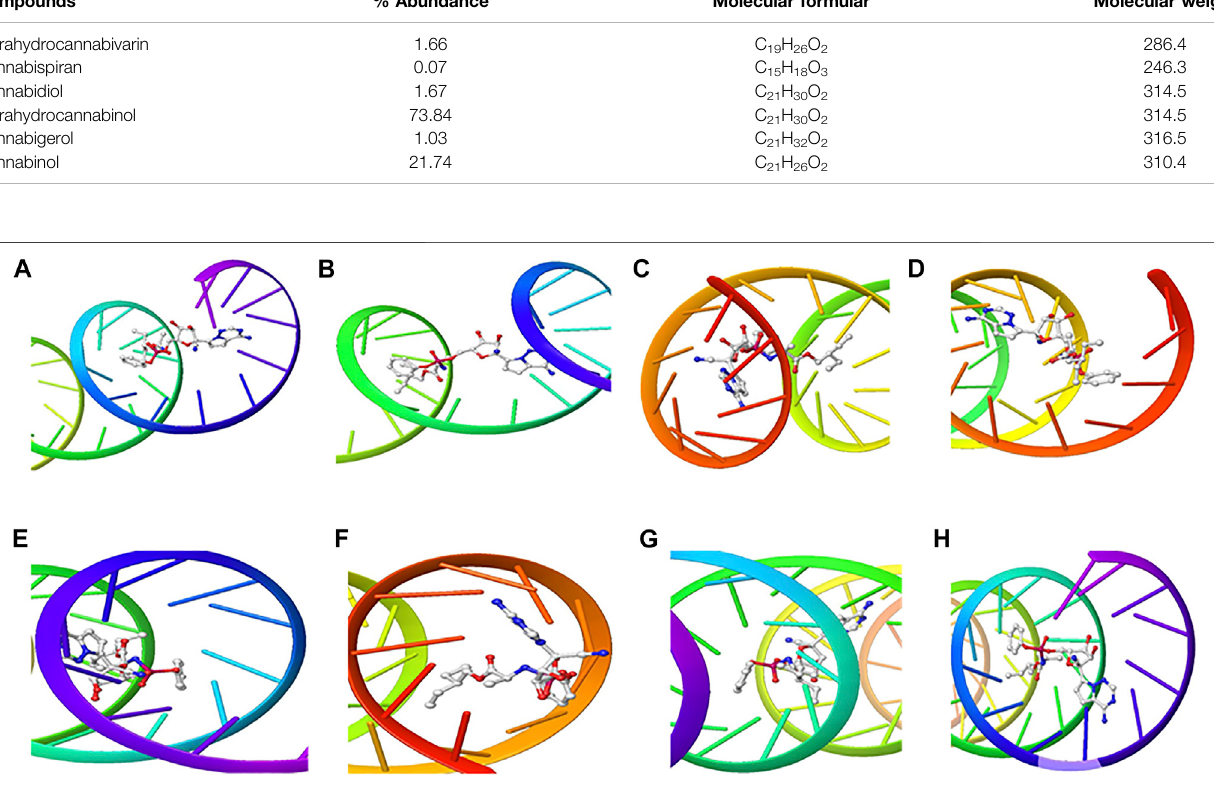
TABLE 3 | GC-MS identi fi ed compounds in C. sativa infusion. Compounds % Abundance